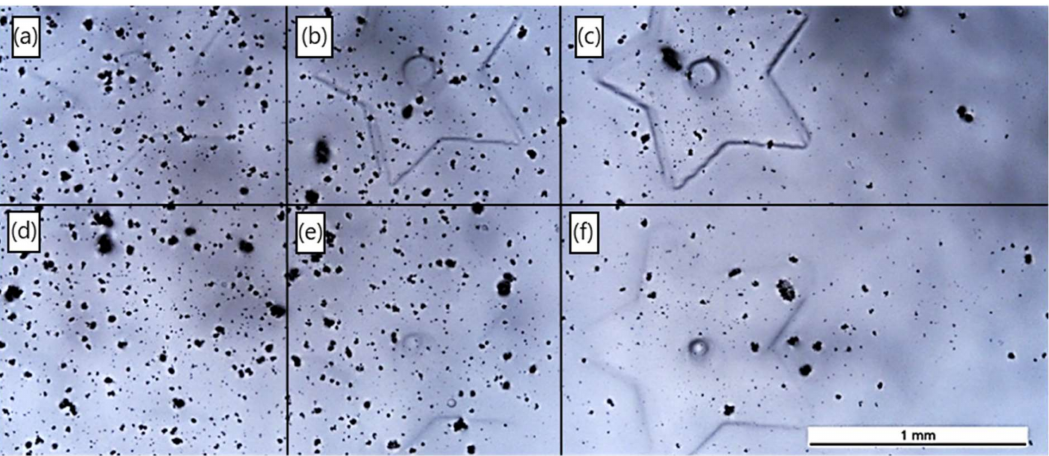
Figure 3. Initial experiments with the 266 nm laser and Ceraset. In the top row ( a–c ), the laser focal point was 6 mm above the surface of the resin. In the bottom row ( d–f ), the laser was 9 mm out of focus. Objects in frames ( a ) and ( d ) were formed with one scan of the star pattern, ( b ) and ( e ) were formed by repeating the pattern four times, and ( c ) and ( f ) were formed with eight repetitions. In all cases, laser power was 0.3 W and hatching distance was 10 µ